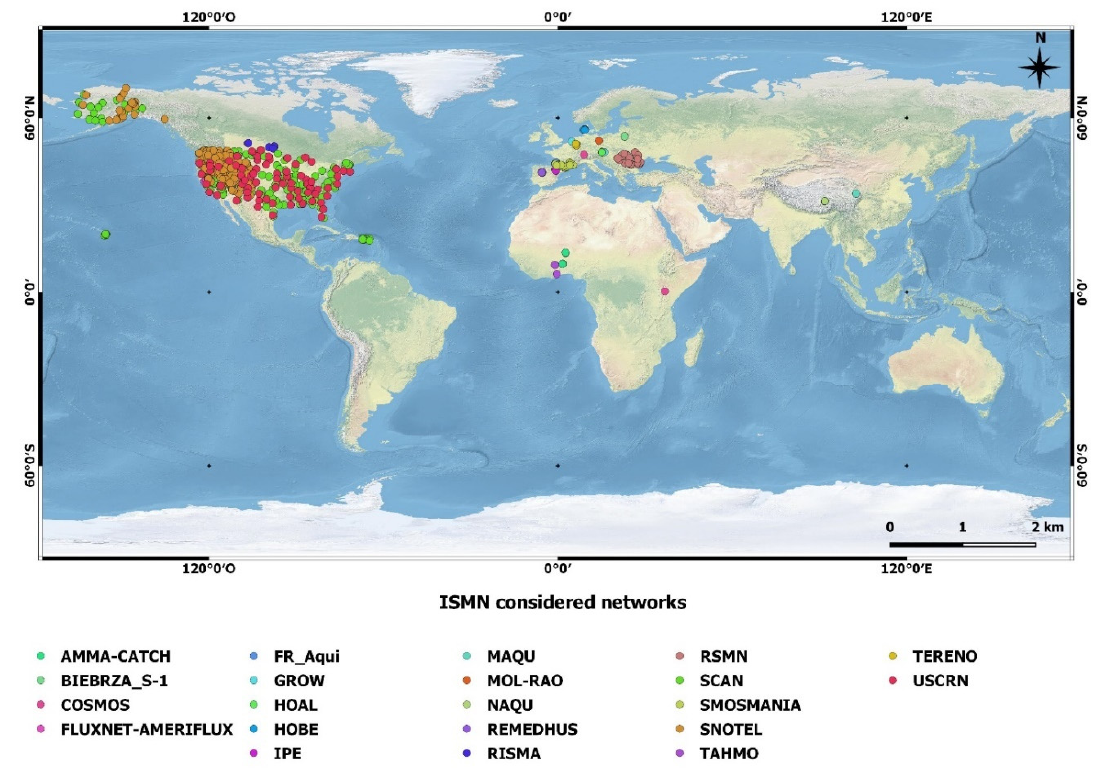
Figure 1. The global distribution of the International Soil Moisture Network (ISMN). Table 1. Overview of the considered ISMN networks.